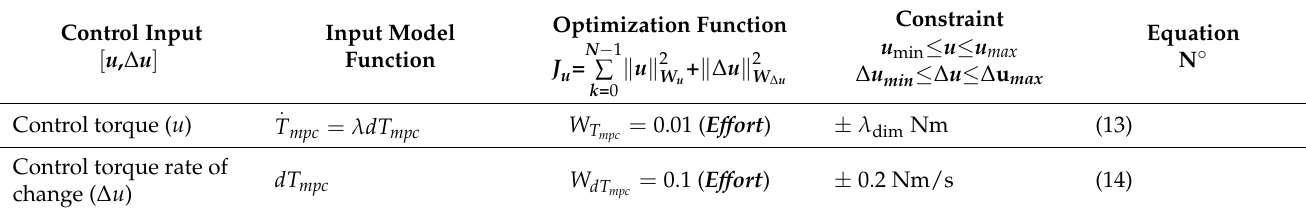
Table 3. NMPC formulation adaptive co-pilot (system control